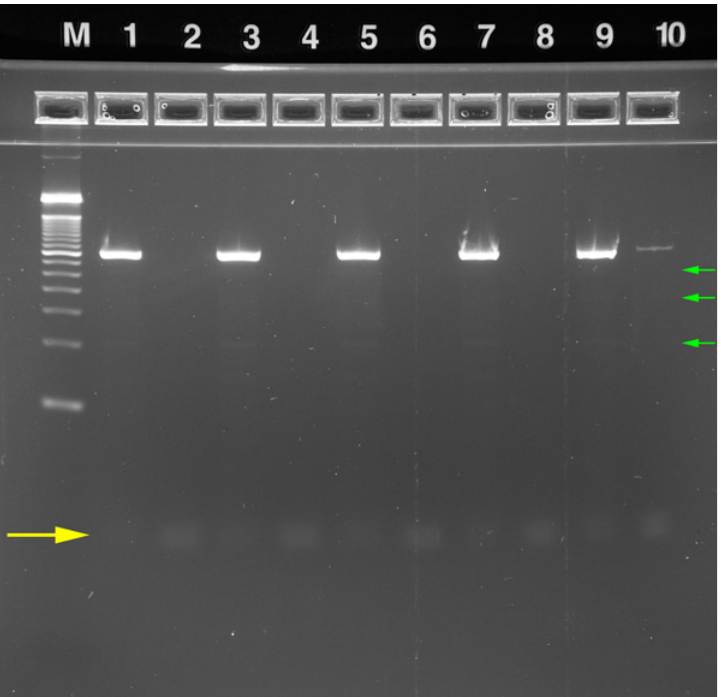
Fig 12. E-Gel image showing sequential 26-cycle Phusion / GAPDH cleaning and decontamination experiments. Odd numbered lanes are identical positive controls preceded by cleaning protocol A. Lanes (M) 50 bp ladder, (2) NTC preceded by cleaning protocol A, (4) NTC preceded by cleaning protocol B, (6) NTC preceded by cleaning protocol C, (8) NTC preceded by cleaning protocol D, (10) NTC preceded by cleaning protocol E. The yellow arrow indicates the position of primer bands, while green arrows indicate faint nonspecific bands in the rzPCR positive control lanes.